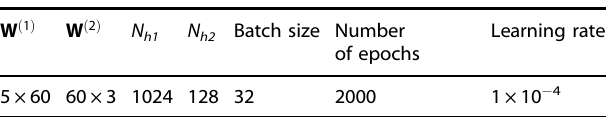
Table 1. Hyperparameters of the optimized GNN model.